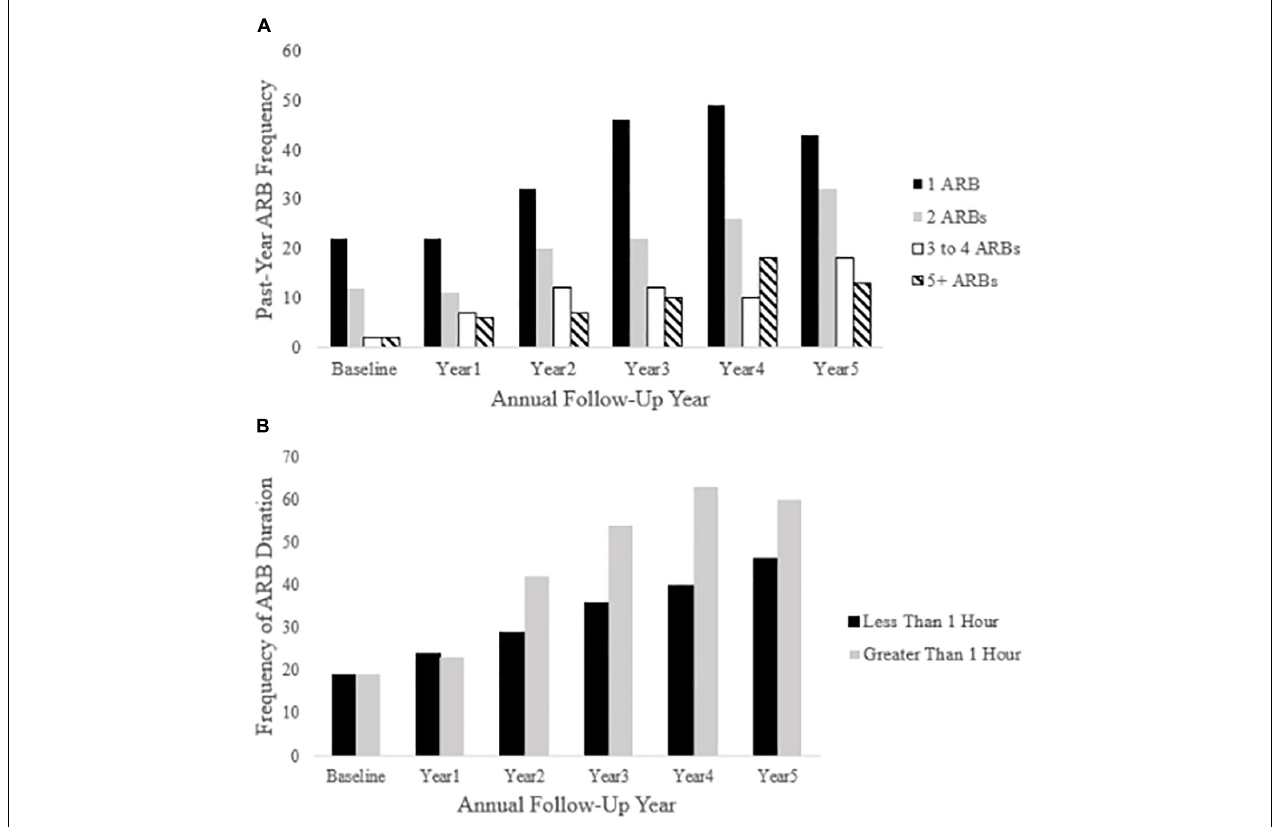
FIGURE 4 | Past-year ARB frequency and longest duration at each annual follow-up. Panel (A) depicts ARB frequency at each annual follow-up (baseline through year five). Panel (B) depicts ARB duration (less than 1 h or greater than 1 h) in participants reporting a past-year ARB history.